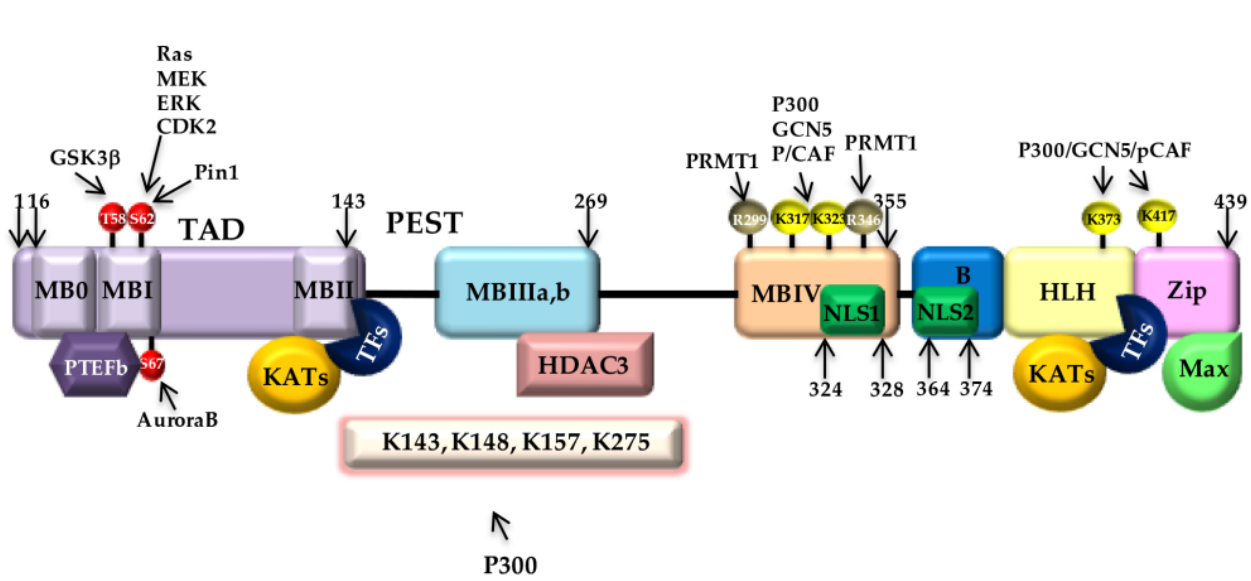
Figure 1. The complex structure of the Myc oncoprotein. Structures of distinct Myc domains, relative post-translationally modified residues, and interacting regions with protein